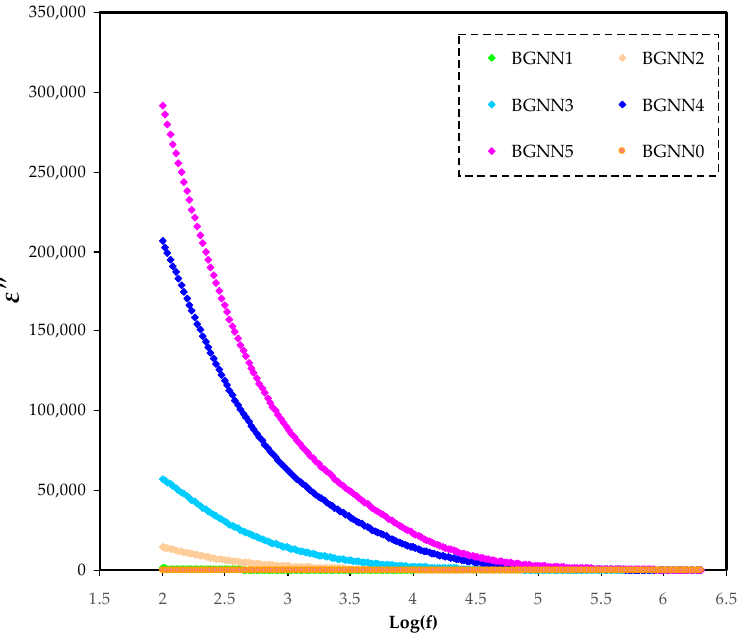
Figure 5. E (cid:48)(cid:48) spectra for the NBG electrolyte systems. Figure 5. ɛ ” spectra for the NBG electrolyte systems. Table 3. Variation of relaxation frequency (f max ) with relaxation time( τ ).